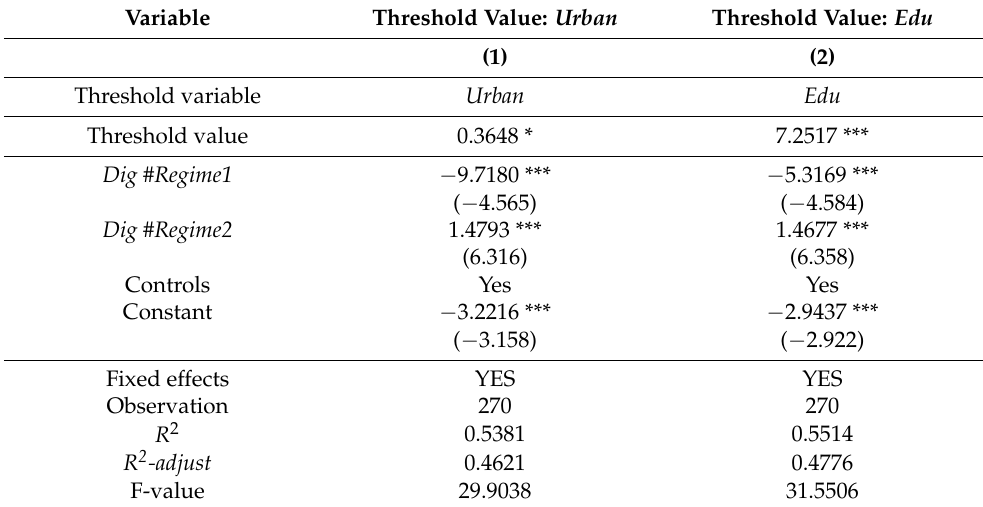
Table 9. Threshold regression